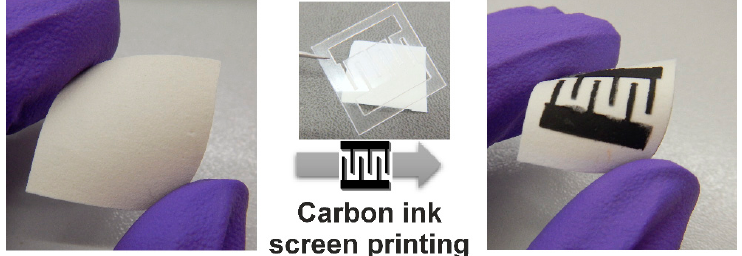
Figure 10. Schematic of the carbon interdigital contacts deposited by inkjet printing on cellulosic substrates.